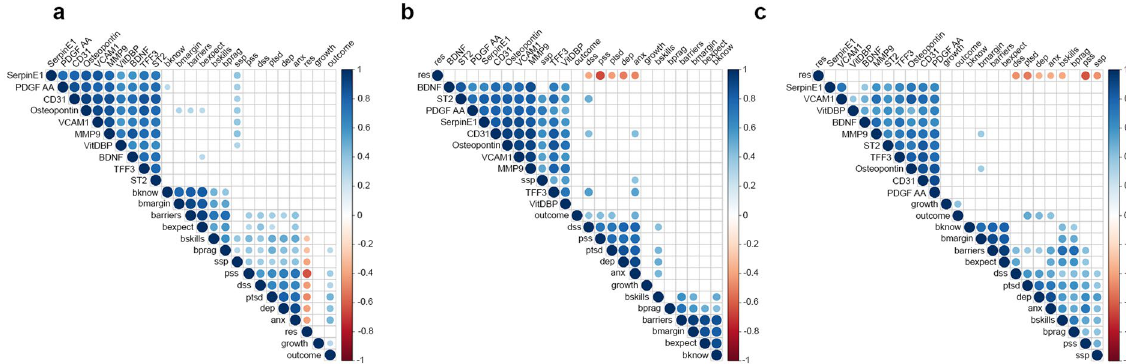
Figure 4. Correlation of top significantly expressed cytokines with psychosocial measurements. Top differentially expressed cytokines (by P -value) were subjected to Spearman correlation analyses to identify associations with psychosocial measurements among ( a ) whole cohort, ( b ) non-cancer participants, and ( c ) cancer survivors group. White squares = no significant association; Blue circles = significant positive association; Red = significant negative associations. Color intensity reflects stronger associations as determined by the correlation coefficient value (Y-axis). P < 0.05. bknow : barriers to care – knowledge and belief; bmargin : barriers to care – marginalization ; barriers: barriers to care - total; bexpect : barriers to care – expectations; bskills : barriers to care – skills; bprag : barriers to care: pragmatics; ssp : social support; pss : perceived stress; dss : distress; ptsd : post-traumatic stress syndrome symptoms; dep : depressive symptomatology; anx : anxiety symptoms; res : resilience; growth : post-traumatic growth; outcome : natural disaster